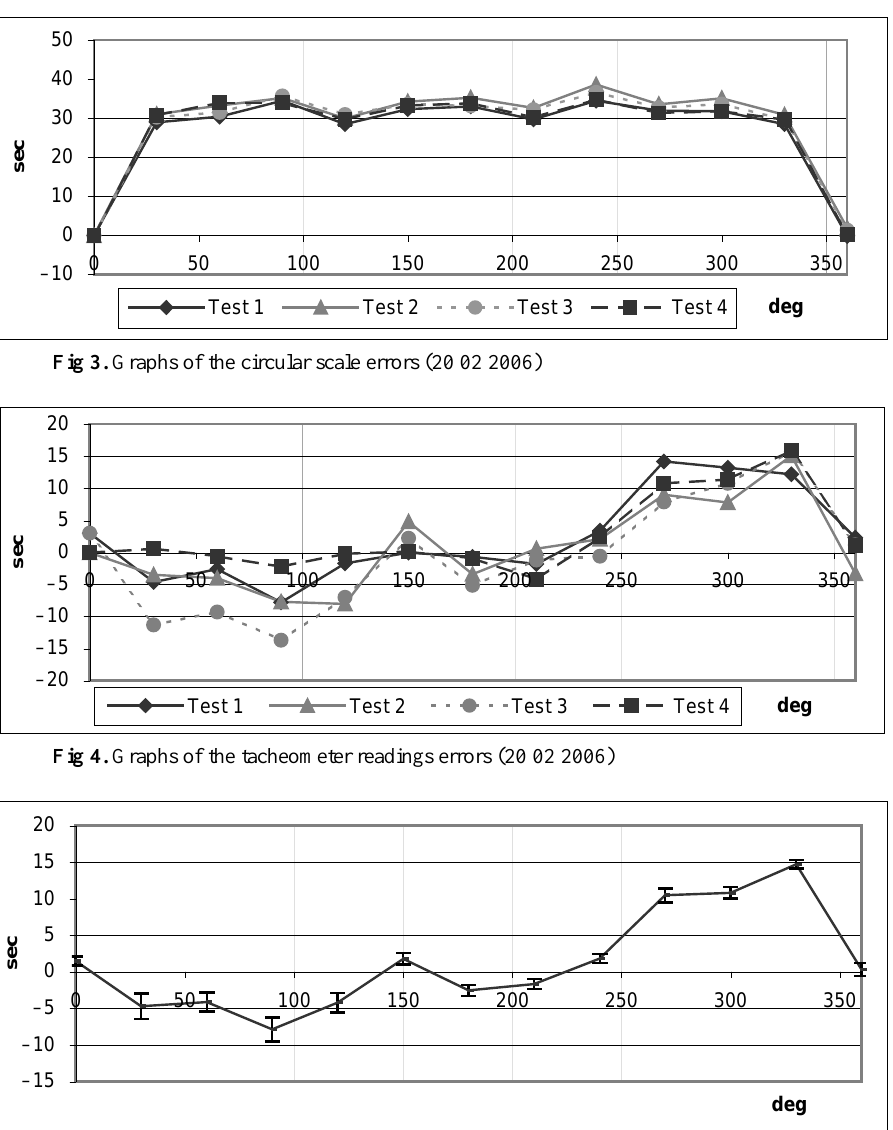
Fig 2. Graphs of readings from the photoelectric autocollimator (20 02 2006)